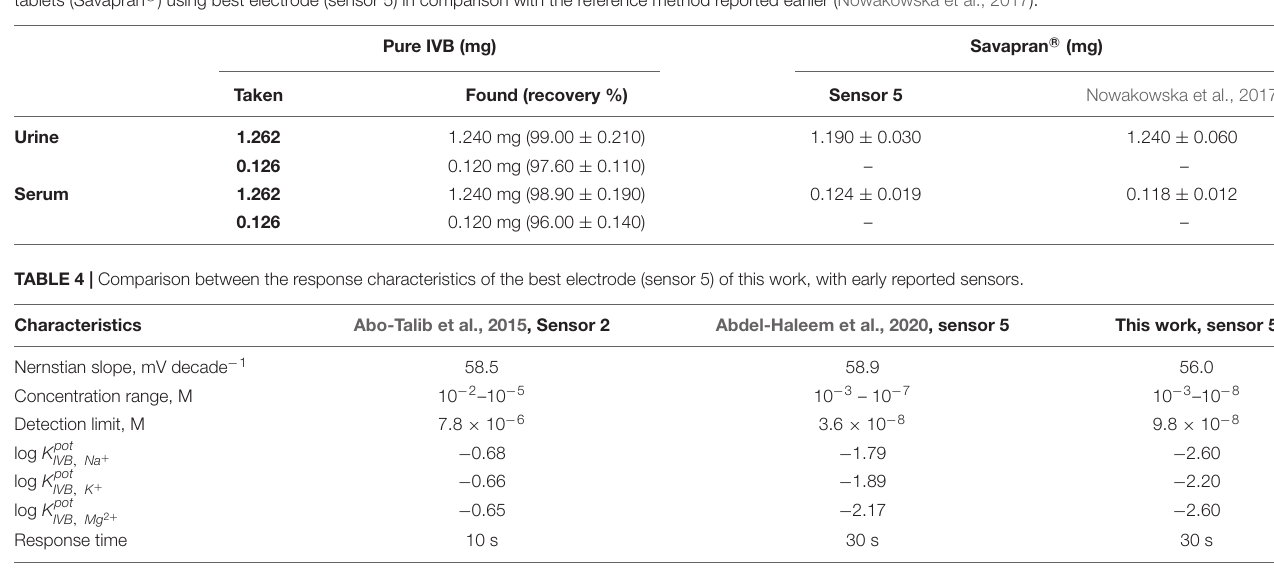
TABLE 3 | Recovery values for determination of pure IVR in spiked urine and serum samples, and results of different amounts of IVR in the commercial pharmaceutical tablets (Savapran R (cid:13) ) using best electrode (sensor 5) in comparison with the reference method reported earlier (Nowakowska et al., 2017).